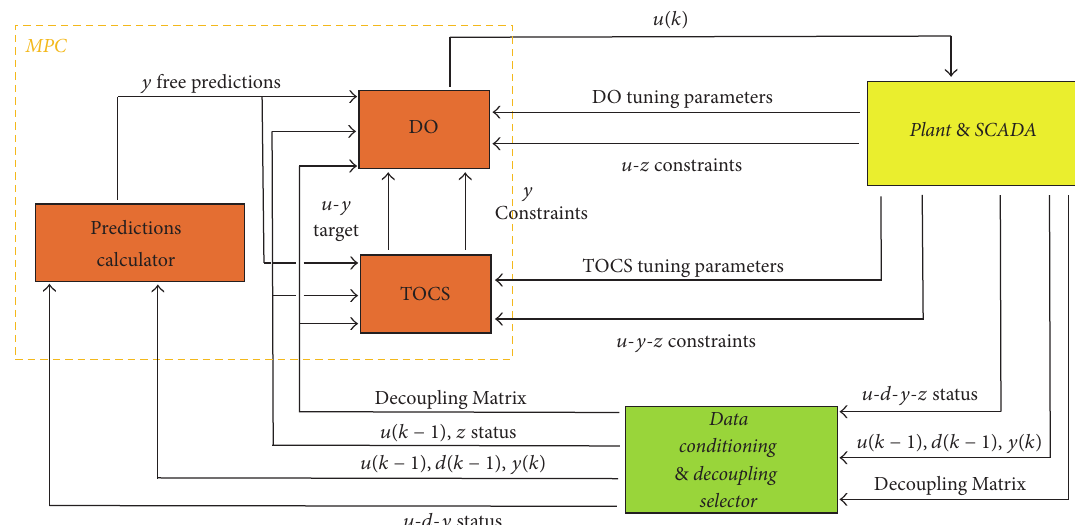
Figure 4: Architecture of the designed APC